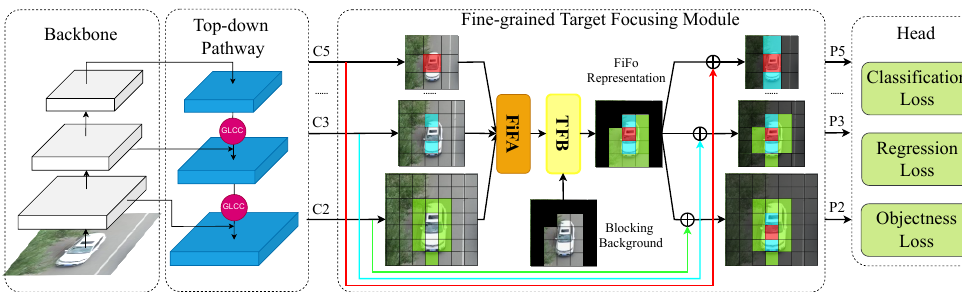
Figure 3. The pipeline of the proposed FiFoNet, which consists of four modules. The first module is a backbone for feature extraction. The second module, which includes our proposed GLCC, is a top–down pathway for extracting multi-scale features. The third module is the newly proposed fine-grained target-focusing module for fine-grained feature aggregation and background noise suppression at the feature level. The last module is a head for predicting classification scores and bounding box positions. These four modules are merged into a unified network for an end-to- end training.